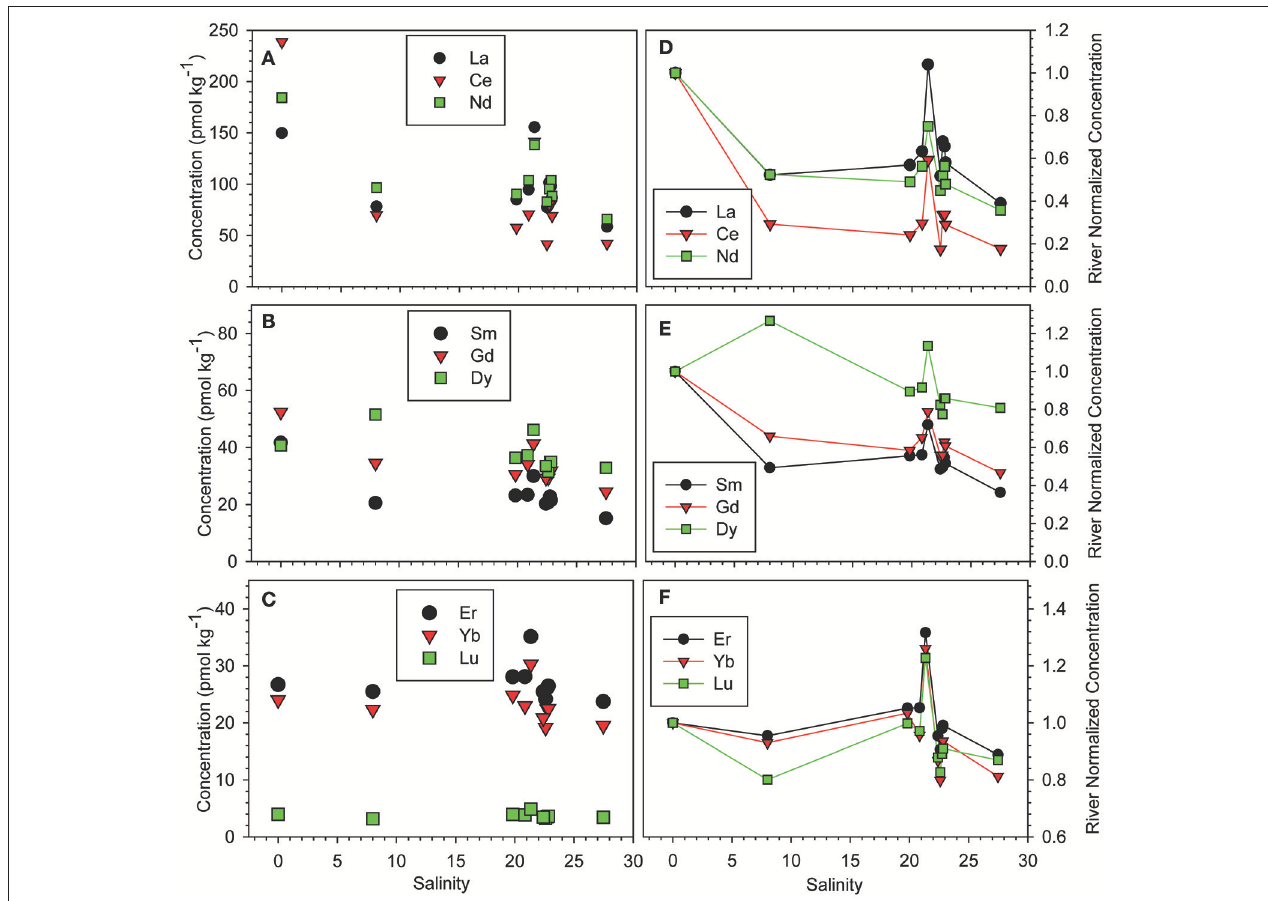
FIGURE 3 | Concentrations of selected (A) LREE (La, Ce, Nd), (B) MREE (Sm, Gd, Dy), and (C) HREE (Er, Yb, Lu) as a function of salinity in the Mississippi River estuary. (D–F) River normalized concentrations of the same selected LREE, MREE, and HREE as a function of salinity in the Mississippi River estuary.